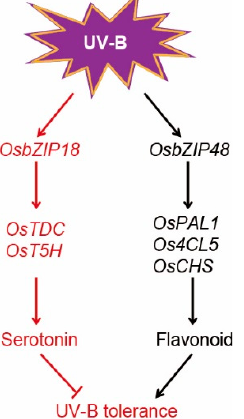
Figure 7. A proposed working model of the role of OsbZIP18 in the regulation of serotonin biosynthesis and UV-B tolerance.